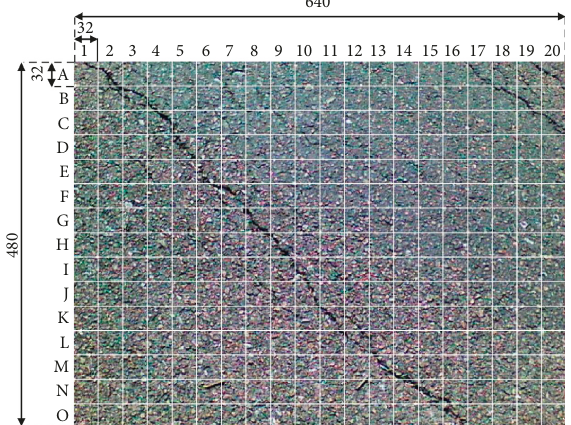
Figure 11: Montaging all 300